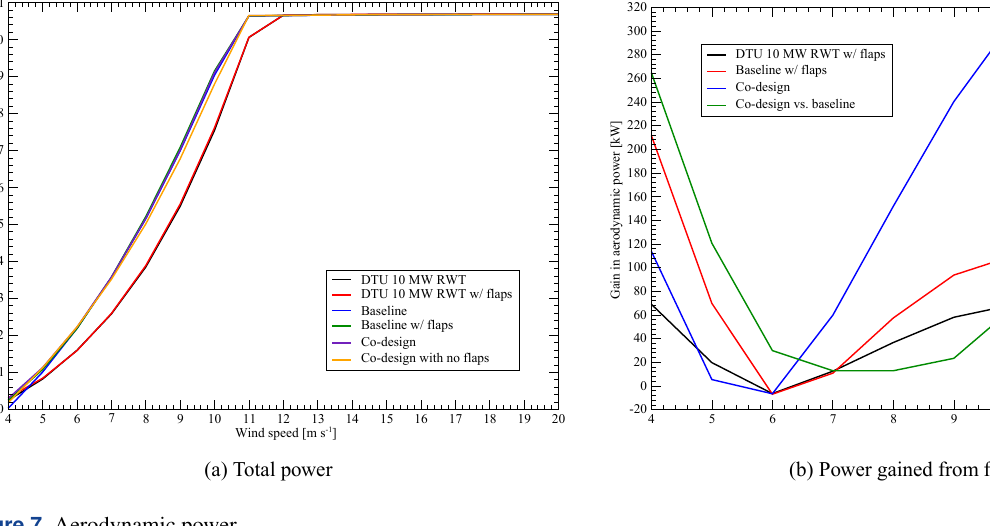
Figure 7. Aerodynamic power.